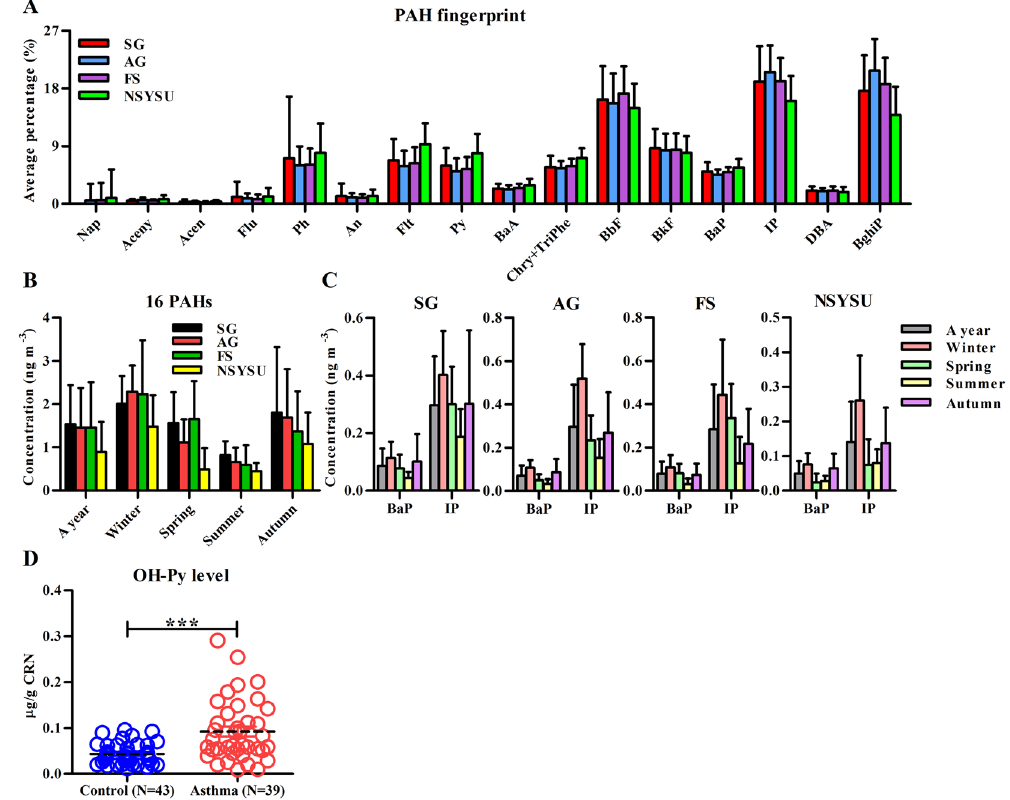
Figure 1. Analysis of ambient PAHs in southern Taiwan and of a surrogate uninary metabolite in a case-control study. ( A ) Normalized PAH composition distributions (mean ± SD) in PM 2.5 in air from the four sampling sites. The description of the sampling sites and the full name of each PAH were summarized in Methods. ( B ) The seasonal variations of 16 PAHs (mean ± SD) in ambient PM 2.5 in each site. ( C ) The difference of PM 2.5 bound BaP and IP concentrations (mean ± SD) in each site and each season. ( D ) Analysis of urinary PAH metabolite, 1-hydroxypyrene (OH-Py), in asthma patients and controls. The levels of normalized urinary OH-Py by the levels of urinary creatinine (CRN) were measured in those with current asthma versus normal subjects, all of whom were non-smokers. Each circle represents each individual result. The line within the vertical points marks the mean for each group. *** P = 0.0001 by Mann-Whitney U